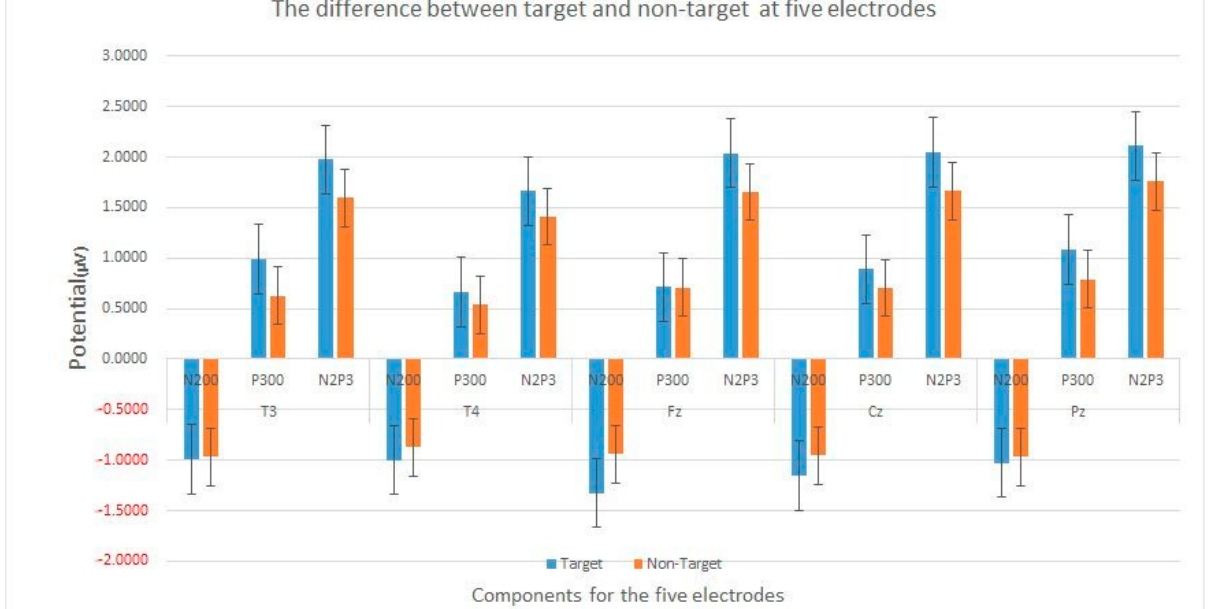
Figure 8. The potential differences between the target and non-target using components N200, P300, and N2P3 of ERPs to classify data from the five electrodes.